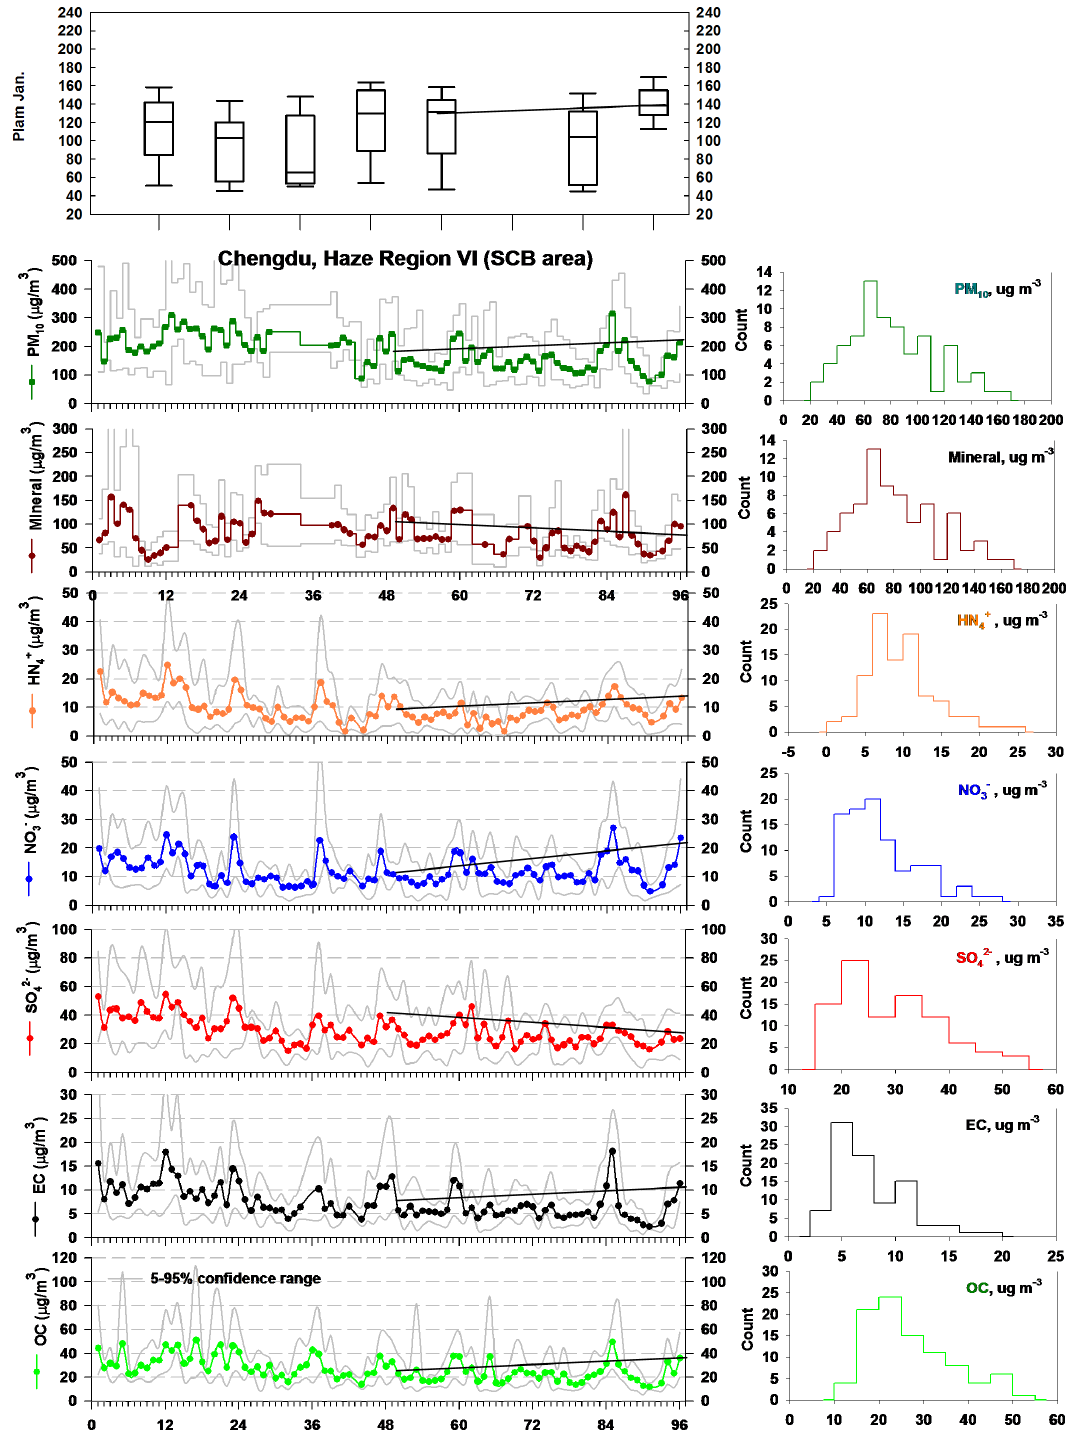
Figure 6. Left panel: change of monthly median concentrations of major chemical components, PM 10 , and January PLAM at Chengdu in haze region VI, one of the major haze region in the Si Chuan Basin (SCB) area in China. Wintertime data were used in linear trend fitting from 2010 to 2013; right panel: histogram analysis result for various chemical